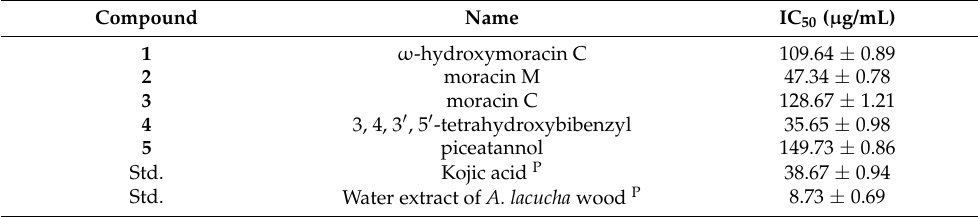
Table 2. IC 50 values of the isolated compounds from S. taxoides on tyrosinase inhibitory activity. Compound